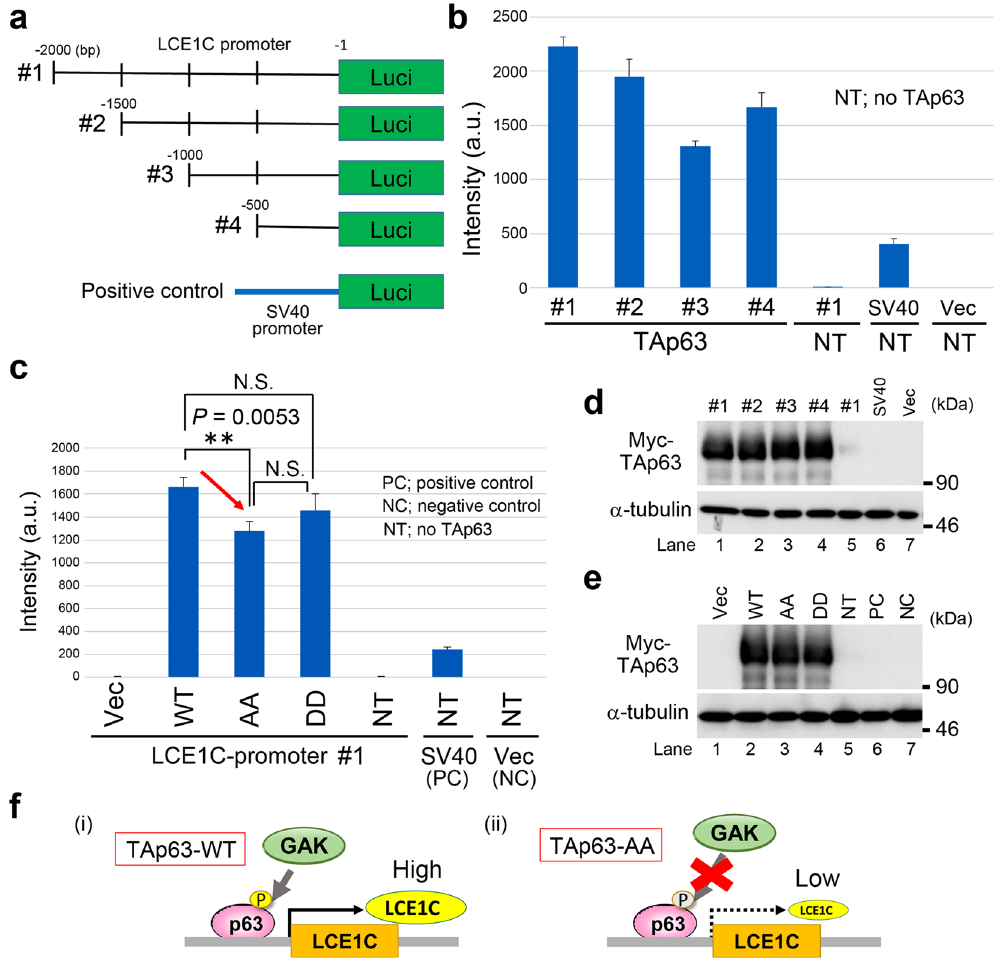
Figure 3. Luciferase reporter assays using the promoter region of the LCE1C gene. ( a ) A schematic representation of the promoter region (~2000 bp) of LCE1C . Green box indicates the location of the luciferase gene. ( b ) Bar graph to indicate the promoter activity of #1–4 promoter regions (arbitrary units). Promoter activity of SV40 promoter was measured as a positive control. Promoter activities using no TAp63 DNA (NT) or vector alone (Vec) in the reaction mixture were also measured as negative controls. ( c ) Bar graph to examine the alteration of the promoter activity of LCE1C-promoter #1 by addition of Myc-TAp63-WT, Myc-TAp63- T46A/T281A (AA), or Myc-TAp63-T46D/T281D (DD) plasmids into the reaction mixture. Promoter activities using no TAp63 DNA (NT) or vector alone (Vec) in the reaction mixture were also measured as negative controls (NC). Addition of SV40 promoter was examined as a positive control (PC). N.S. indicates no significant difference. ( d,e ) Wb to confirm the exogenous expression of Myc-TAp63 in luciferase assays. α -tubulin was detected as a loading control. ( f ) A schematic representation of the action of the GAK_TAp63-T46/T281_ LCE1C axis (i), which was destroyed in the Myc-TAp63-T46A/T281A (AA) expressing cells